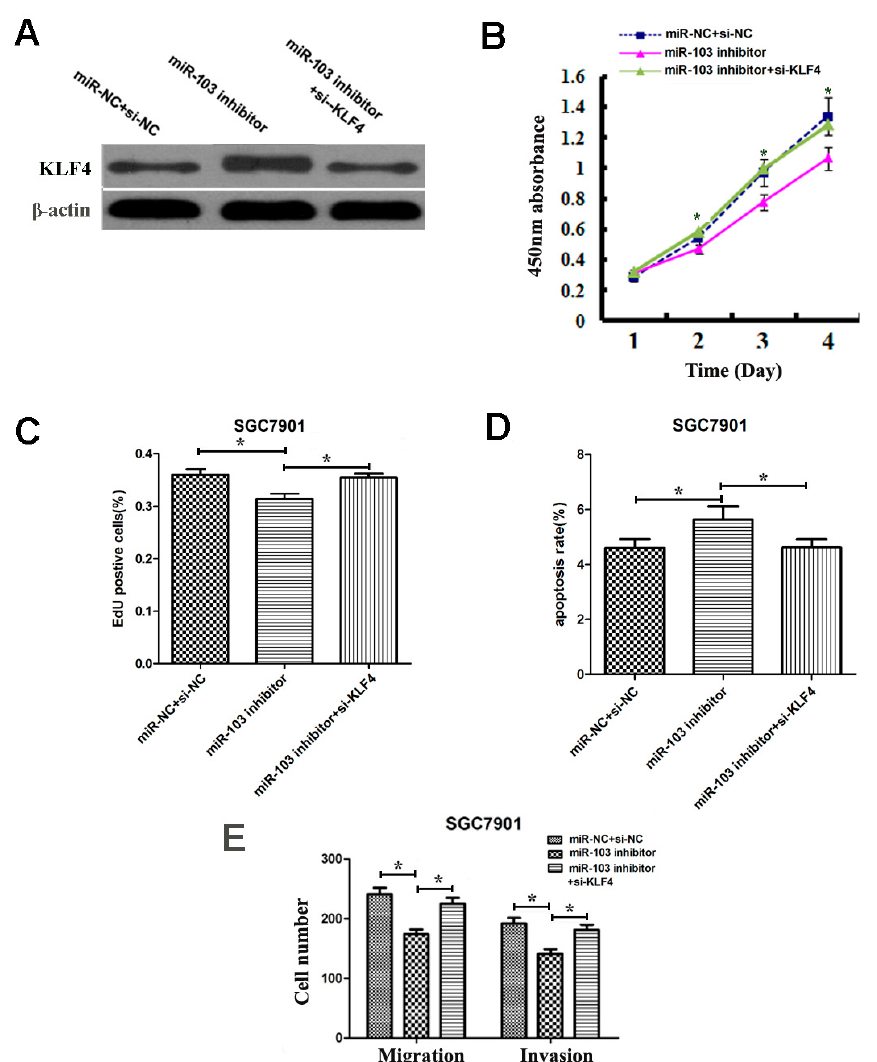
Figure 6. Downregulation of KLF4 rescues miR-103’s oncogenic effect on GC cell proliferation, apoptosis, migration, and invasion in SGC7901cells. ( A ) KLF4 protein expression was detected in SGC7901 cells co-transfected with miR-103 inhibitor/miR-NC and KLF4 siRNA or si-NC; ( B – E ) Cell proliferation, apoptosis, migration and invasion were assessed in SGC7901 cells co-transfected with miR-103 inhibitor/miR-NC and KLF4 siRNA or si-NC. * p < 0.05; the data represent the mean ± SD from triplicate measurements.